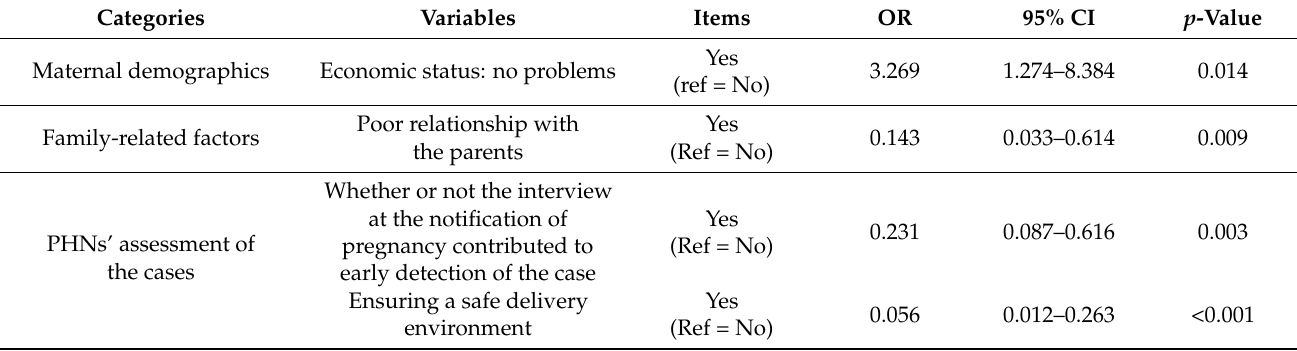
Table 3. Variables associated with early registration as high-risk cases of child maltreatment ( N =